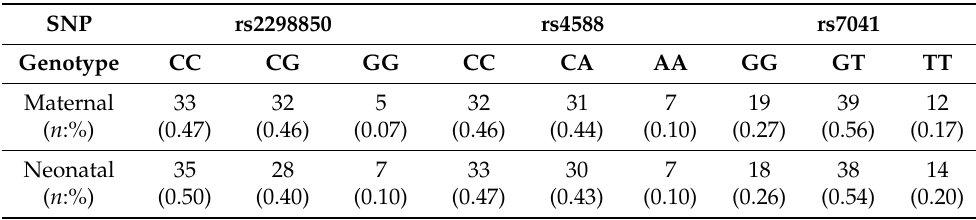
Table 2. Vitamin D binding protein single nucleotide polymorphisms genotype distributions of mothers and neonates